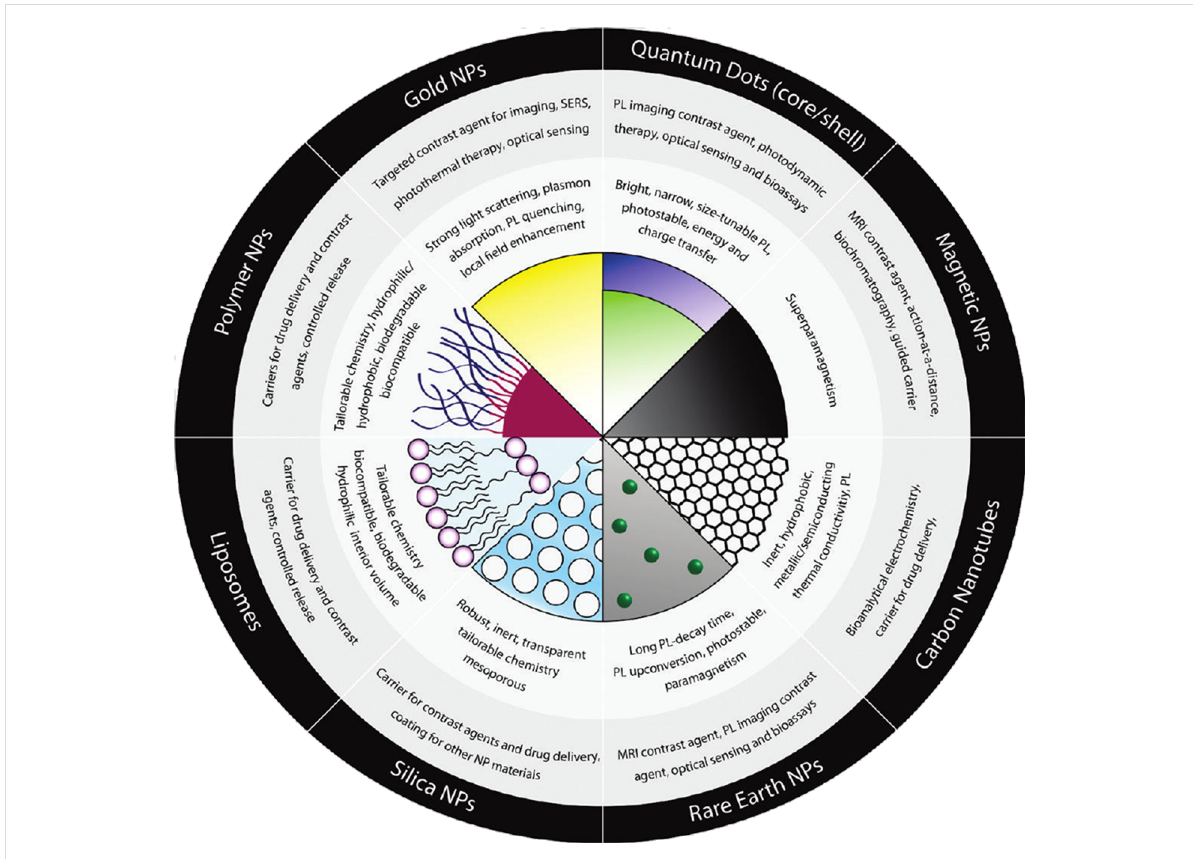
Figure 1: An overview of the “zoo” of different NPs concerning their composition, functionality, and fields of application. Reproduced with permission from [11]. Copyright (2011) American Chemical Society.